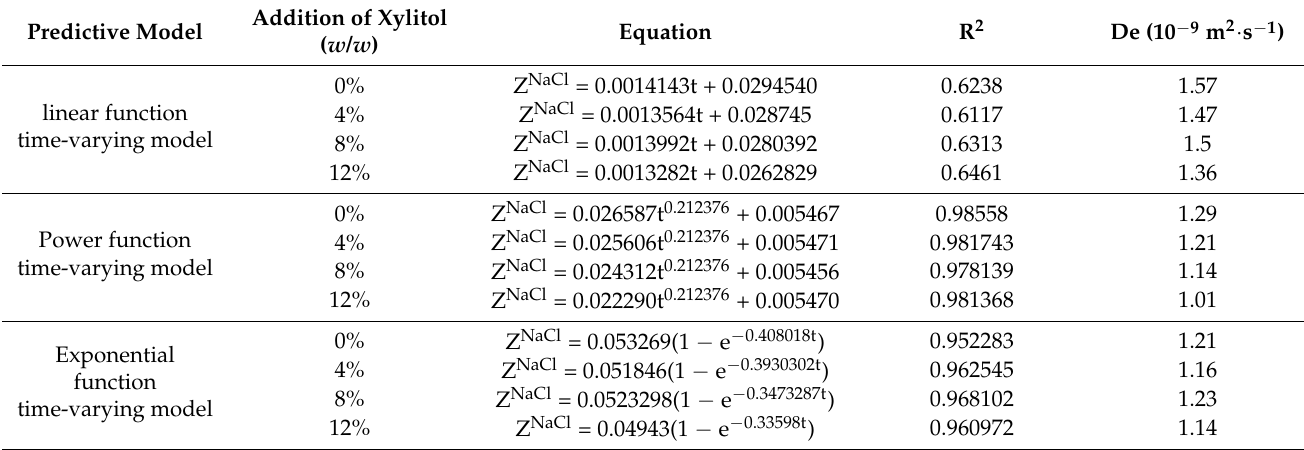
Figure 3. Fitted equations of time and NaCl content with 4% xylitol in pork tenderloin ( a ) and 3D grid model of pork tenderloin ( b ). Table 2. Equations of three prediction models and calculated De values.